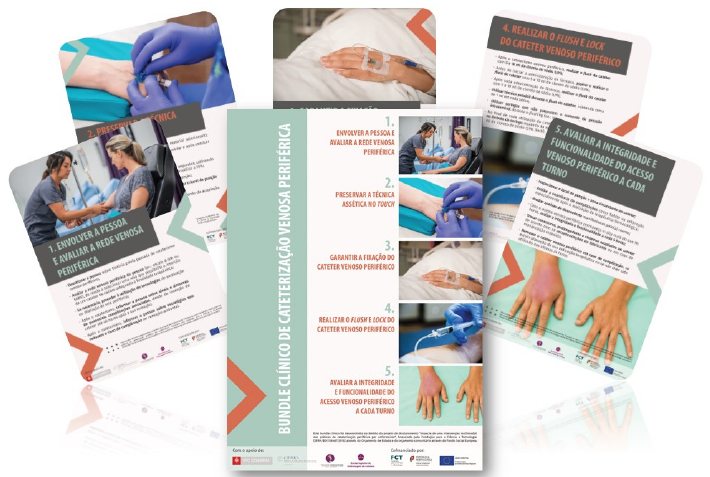
Figure 3. The graphic representation of the developed PIVC